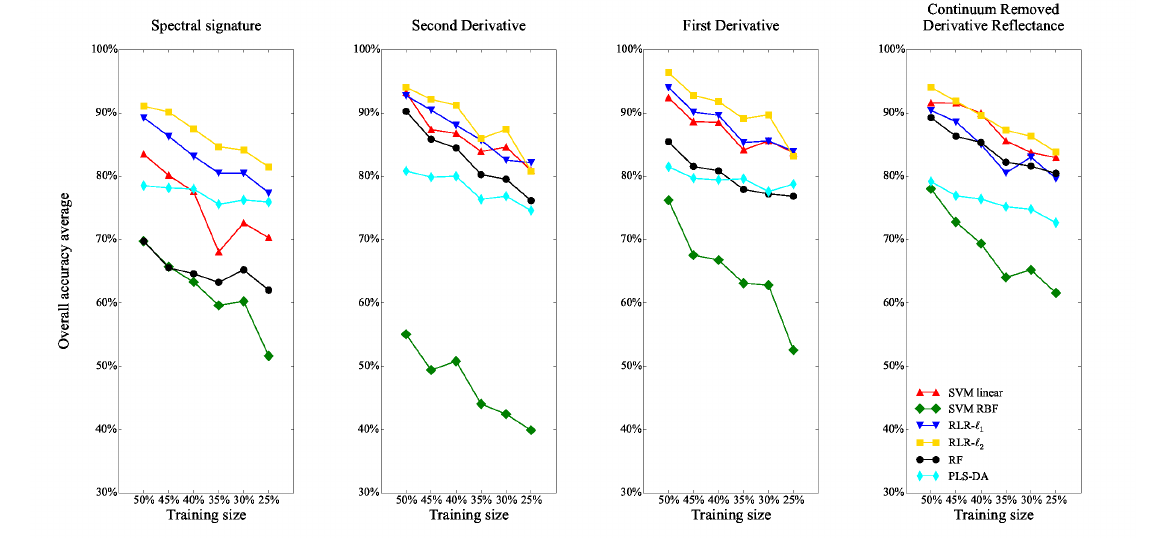
Figure 16. Vegetation type identification accuracies on [350–1350